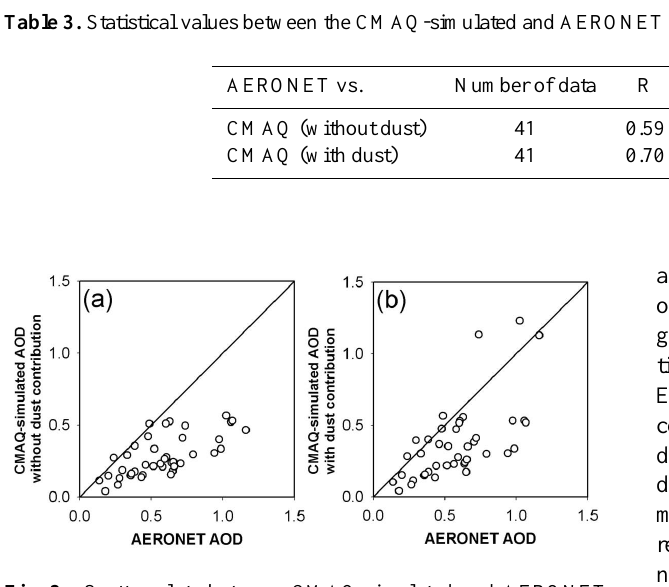
Fig. 3. Scatter plots between CMAQ-simulated and AERONET AODs in spring, 2006: (a) CMAQ-simulated AODs without dust contributions vs. AERONET AODs and (b) CMAQ-simulated AODs with dust contributions vs. AERONET